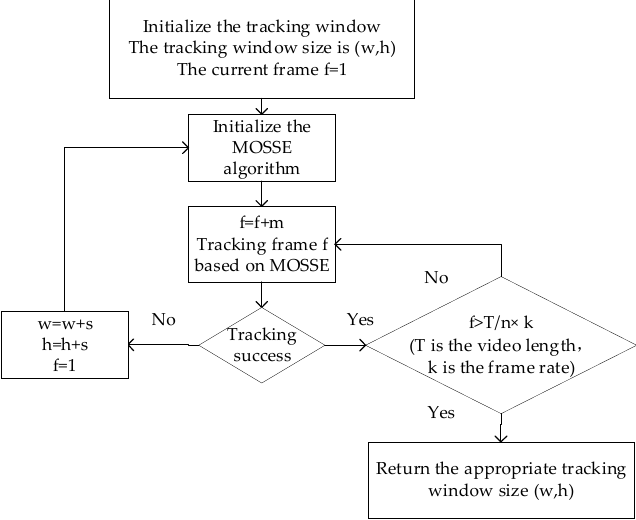
Figure 3. Flowchart of the adaptive construction method of the tracking window.